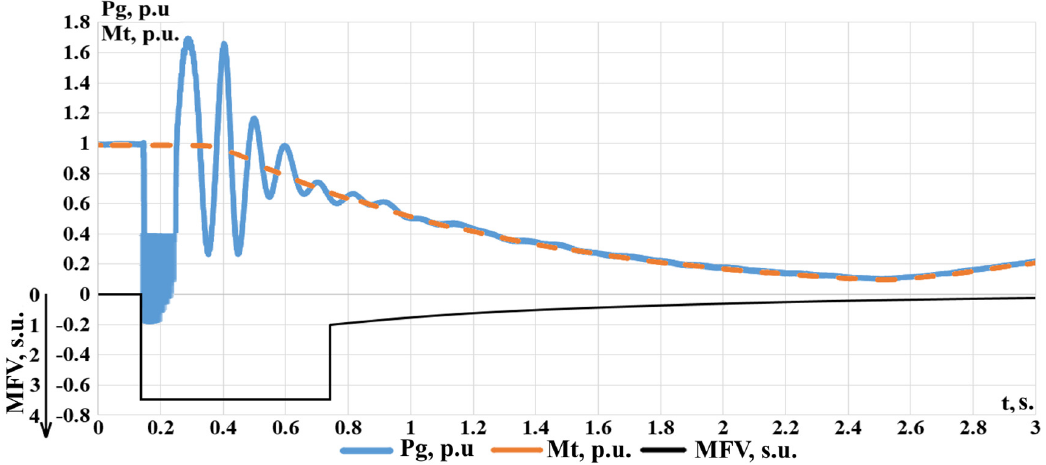
Figure 18. Generator G 2 active power and turbine torque for a case of FV ( A i = 3.5 pu, T MFV = 0.6